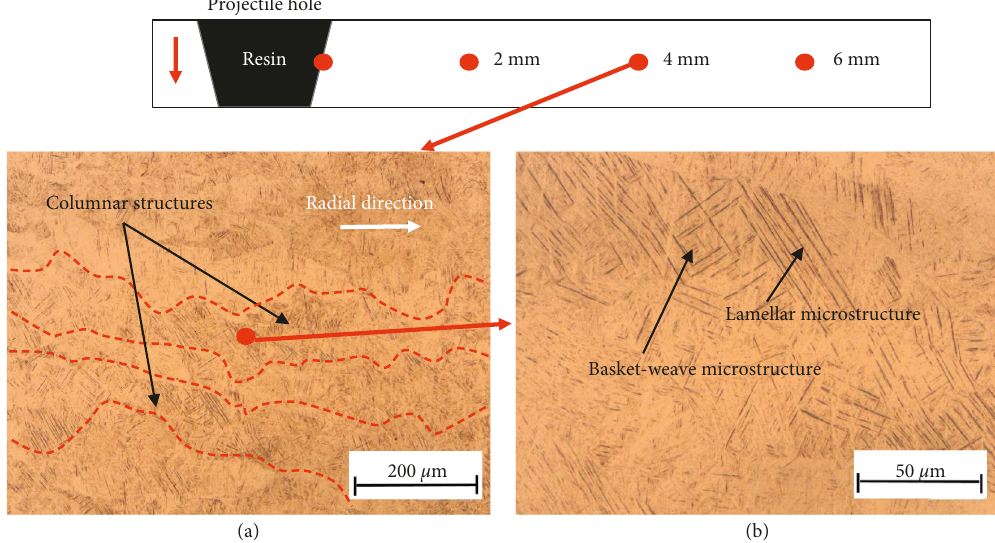
Figure 18: (a) Optical micrograph and (b) higher magnification optical micrograph, both at 4mm from the edge of the projectile hole through a 10mm thick plate.